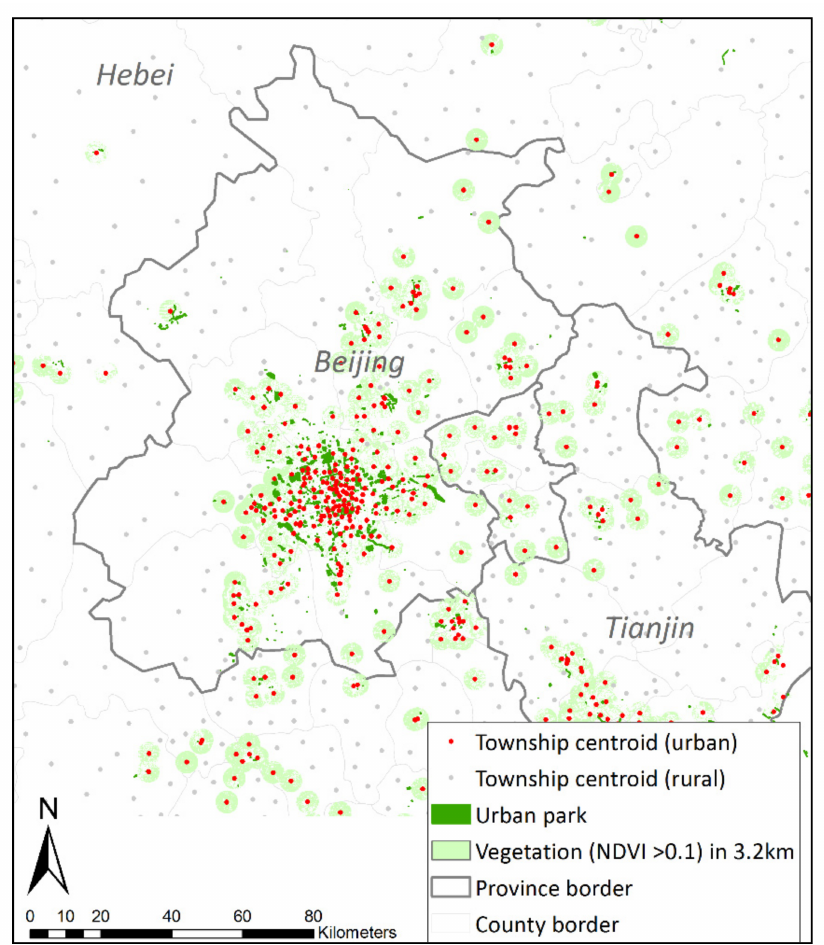
Figure 2. Townships defined as urban area and urban green space (UGS) distributions in